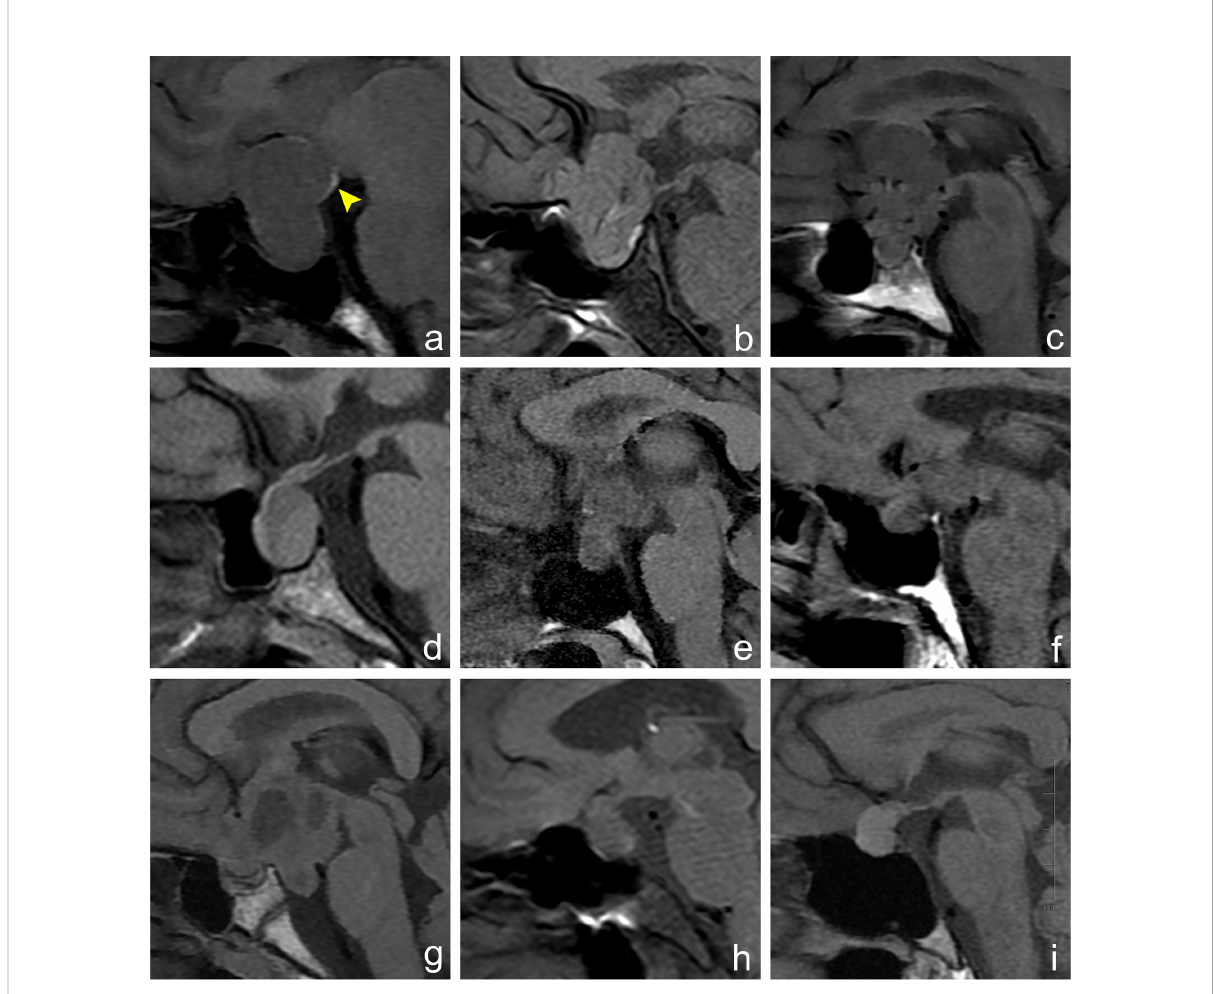
FIGURE 2 Imaging manifestations of hyperintense signal in posterior pituitary in different sellar diseases. Figures (A – I) show an MRI sagittal T 1 WI non- enhanced scan of different lesions in the sellar region. (A) A 30-year-old female, pituitary macroadenoma, ectopic hyperintense signal in the posterior pituitary, which is located at the posterior upper edge of the tumor (arrowhead). (B) A 64-year-old male, meningioma, normal hyperintense signal in the posterior pituitary, which is located behind the intrasellar adenohypophysis. (C) A 39-year-old male, craniopharyngioma, hyperintense signal in the posterior pituitary disappears. (D) A 54-year-old female, Rathke cleft cyst, hyperintense signal in the posterior pituitary disappears. (E) A 35-year-old female, germ cell tumor, hyperintense signal in the posterior pituitary disappears. (F) A 60- year-old male, metastatic tumor, hyperintense signal in the posterior pituitary disappears. (G) A 14-year-old female, glioma, hyperintense signal in the posterior pituitary disappears. (H) A 56-year-old female, cryptococcal granuloma of pituitary, hyperintense signal in the posterior pituitary disappears. (I) A 40-year-old female, abscess of the pituitary, hyperintense signal in the posterior pituitary